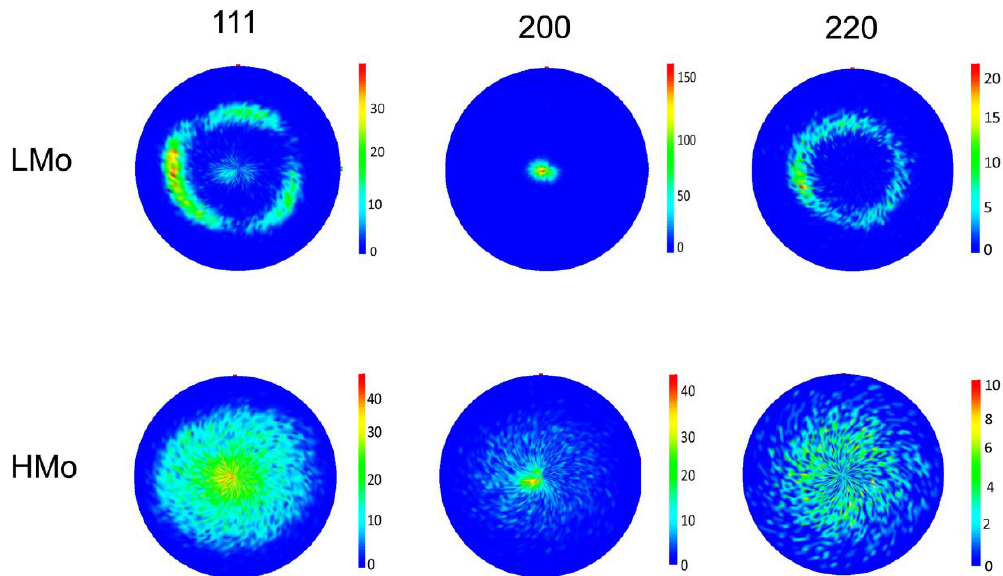
Figure 3. Pole figures for orientations 111, 200 and 220 as obtained by X-ray diffraction (XRD) for samples LMo and HMo. The normal vector of the film surface is perpendicular to the plane of the pole figures.